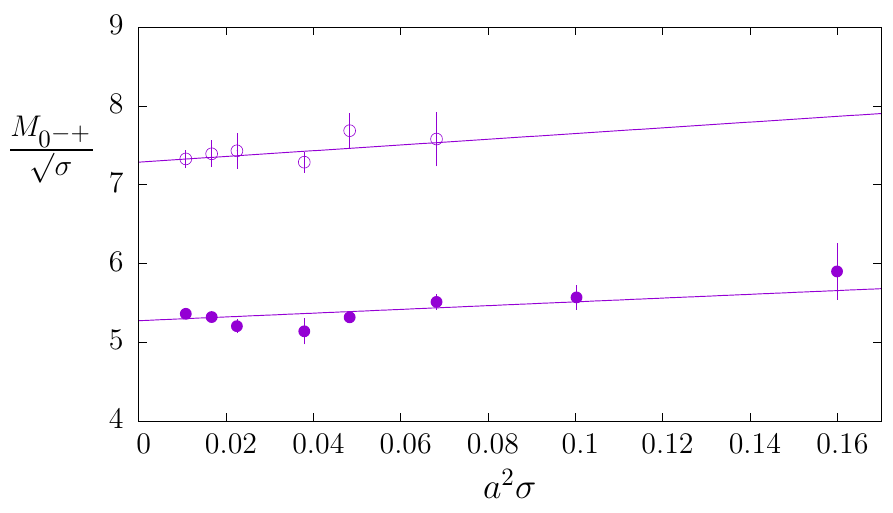
Figure 16 . Continuum extrapolation of the two lightest J PC = 0 − + glueballs as obtained from the lightest two states of the A 1 − +